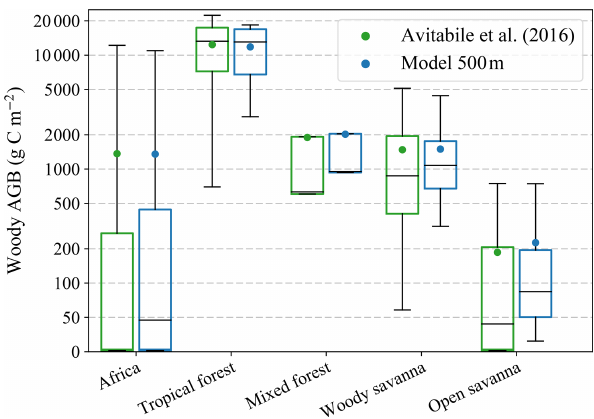
Figure 1. Area-averaged woody aboveground biomass (AGBw) for sub-Saharan Africa as a whole and for individual biomes with sig- nificant tree cover area. Both modelled values (500m) and those derived from the reference AGBw dataset by Avitabile et al. (2016) are shown. Boxplots show the mean (dots), median (horizontal line), 25th and 75th percentiles (boxes), and the 5th and 95th percentiles (whiskers). The 5th and 25th percentiles for Africa and the open- savanna biome approach zero due to an abundance of pixels where AGBw is